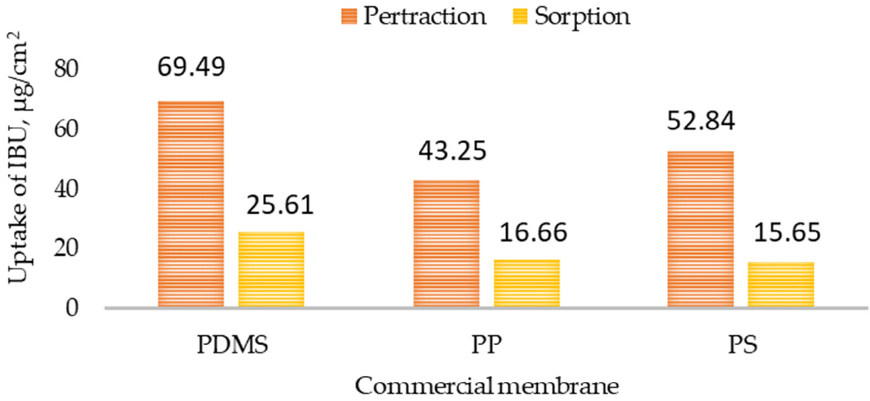
and sorption. Figure 10. The calculated uptakes of IBU per cm 2 of the commercial membrane in both pertraction